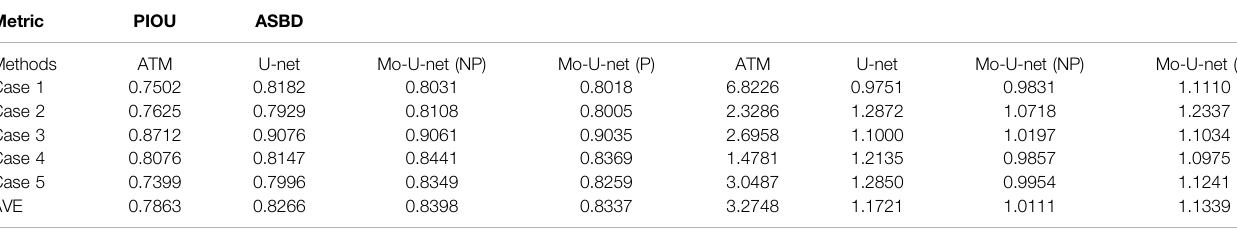
TABLE 2 | The test results of PIOU and ASBD. Metric